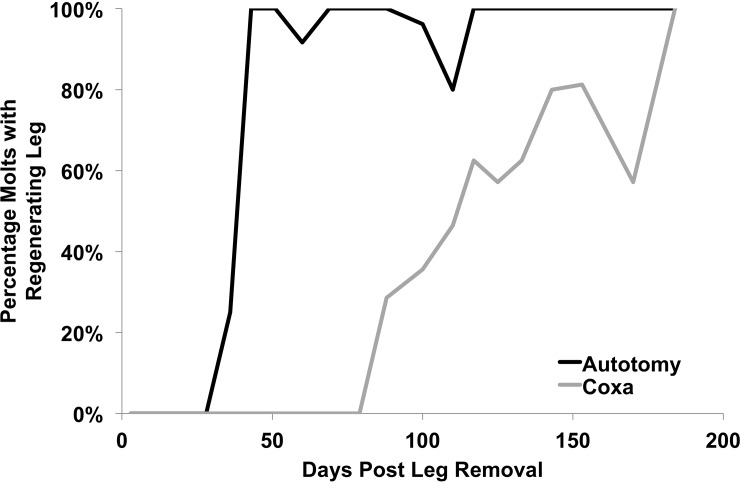
Percentage of new molts with a regenerated leg.Y–axis refers to the percentage of molts observed at the indicated time point that revealed a regenerated leg. After day 43 post-leg removal, in the autotomy group, almost all molts contained a regenerated leg. Similar observations were delayed in the coxa-cut group. The dip at day 110 in the autotomy group (12 of 15 observations showing a regenerated leg) and at day 170 in the coxa-cut group (4 of 7 observations showing a regenerated leg) is likely due to molt failure, with the already regenerating leg self-autotomizing during the molt.